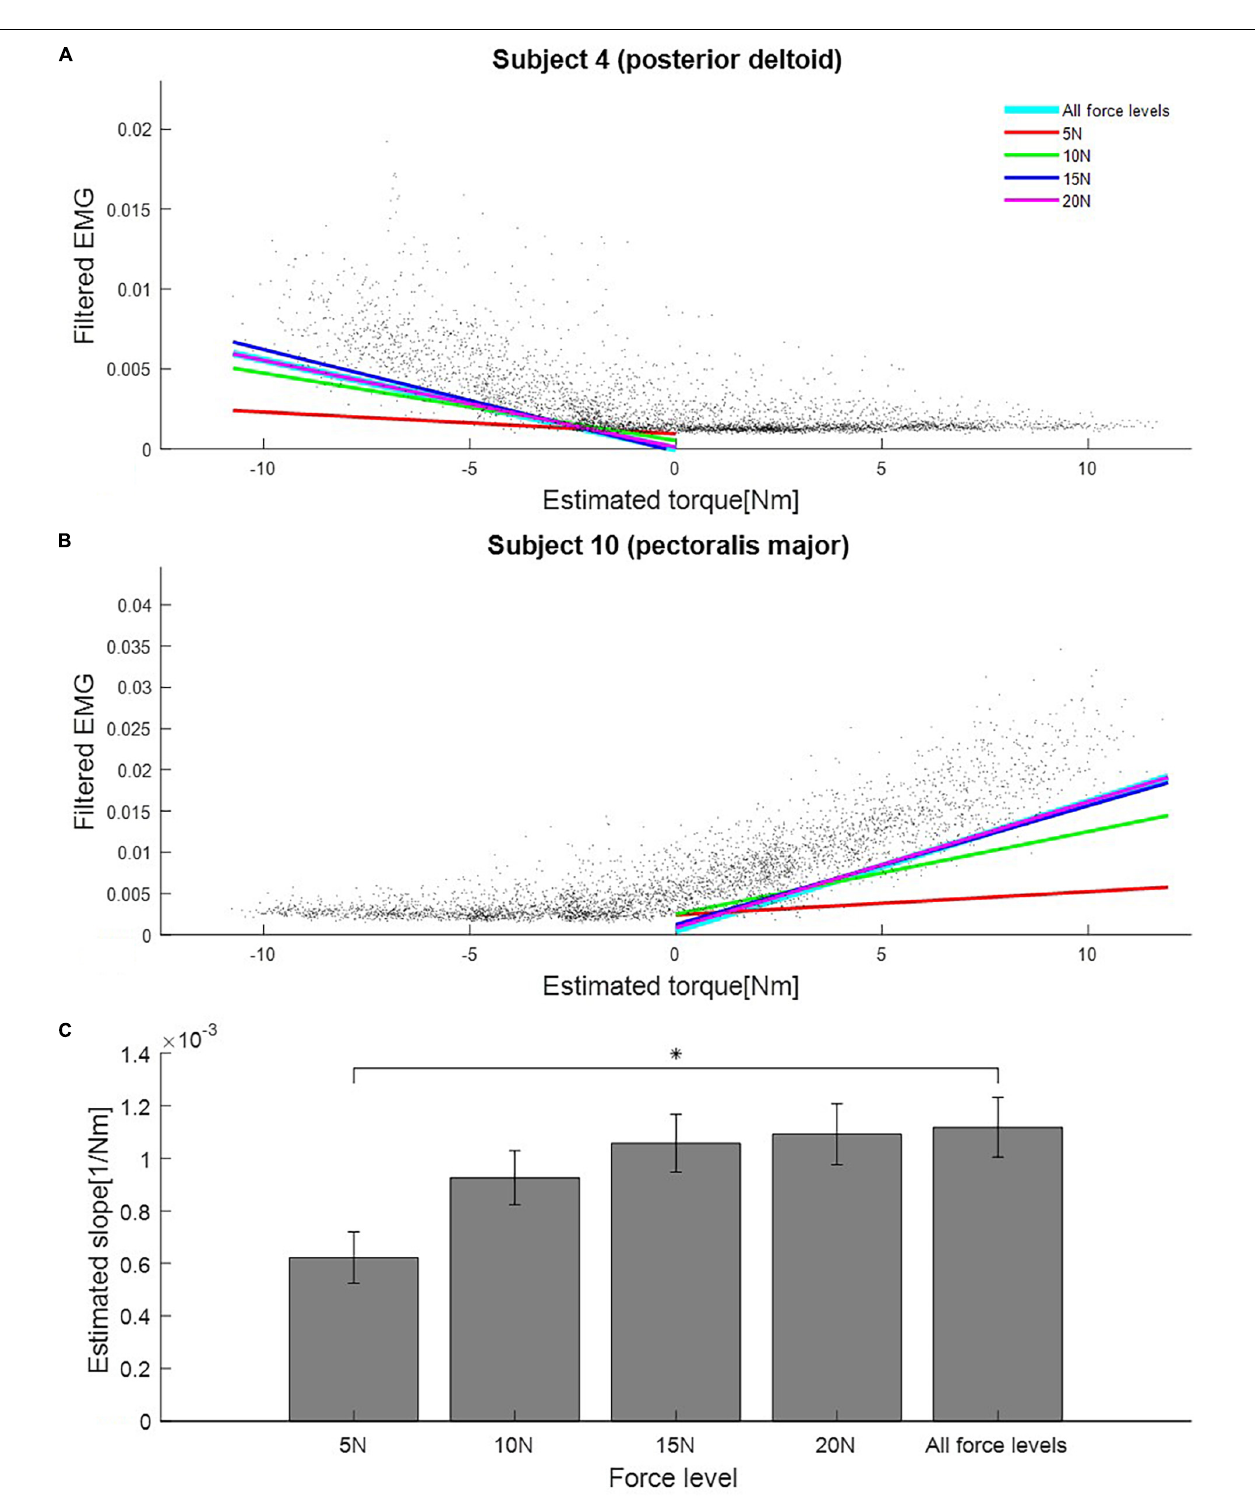
FIGURE 5 | Estimated slopes for joint torque normalization procedure at different force levels in the rotating task. (A) Slopes estimated from data of each force level in the rotating task (Subject 4, posterior deltoid). Black dots are samples of estimated torque and EMG. Colored lines represent regression lines between estimated torque and EMG for each force level. (B) Slopes estimated from data of each force level in the rotating task (Subject 10, pectoralis major). (C) Mean estimated slopes for joint torque normalization for all force levels in the rotating task. Asterisk indicates statistical significance. Error bars indicate the standard error across all muscles and